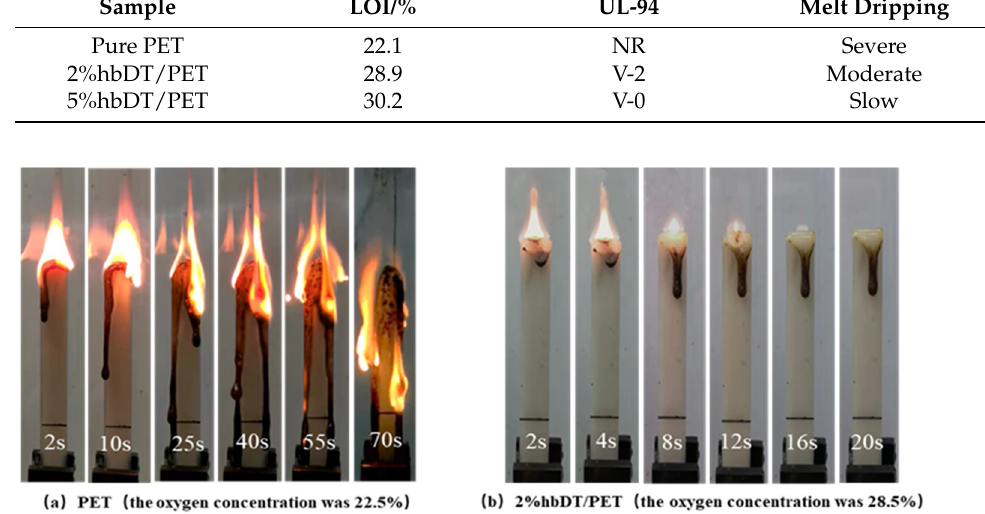
Figure 5. Digital photographs of ( a ) pure PET and ( b ) 2%hbDT/PET composite during the LOI test.